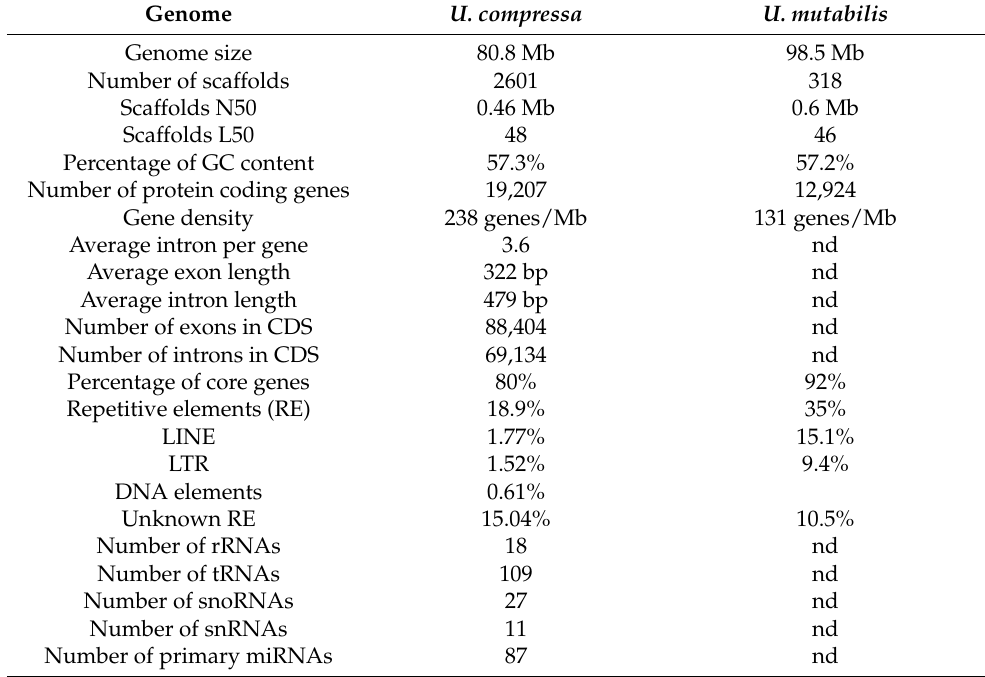
Table 1. Summary statistics of U. compressa genome and comparison with U. mutabilis